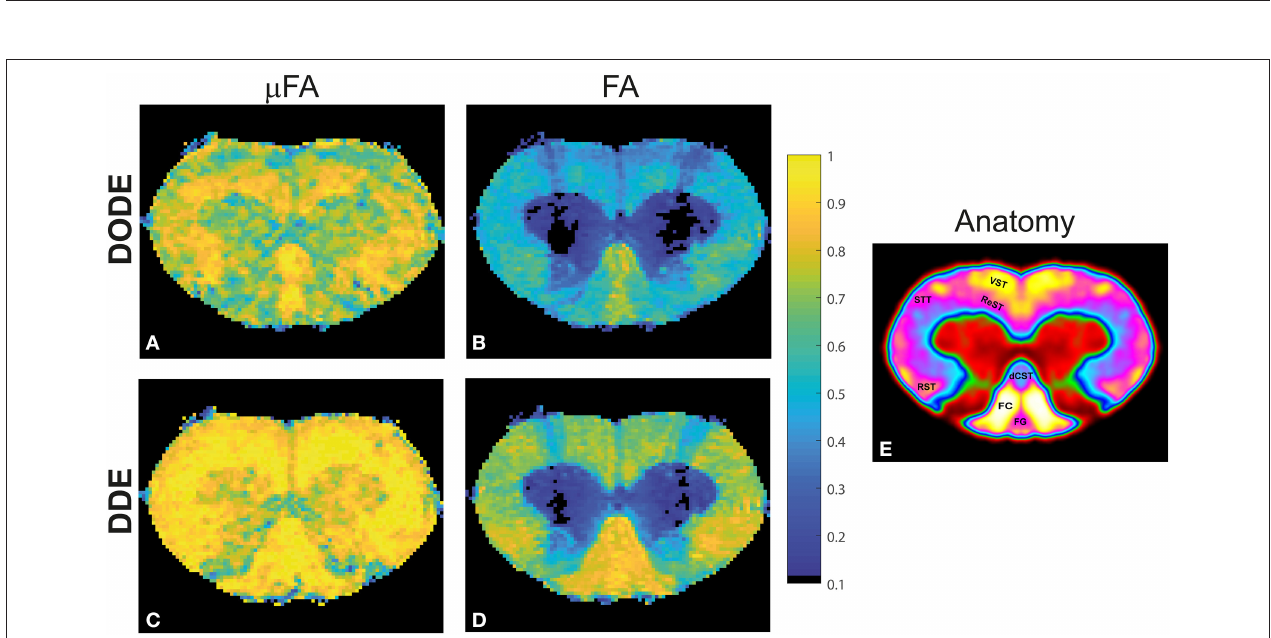
FIGURE 3 | Parameter maps for a representative spinal cord. (A) µ FA DODE ; (B) FA DODE ; (C) µ FA DDE ; (D) FA DDE . Notice the differences in contrast both in white and in gray matter tissues both between metrics and between sequences. Most notably, µ FA is higher than FA and DDE-driven metrics are higher than DODE-driven metrics, especially in white matter. (E) Anatomy of the spinal cord for reference, displayed over a smoothed false-color image of the cervical segment. The gray matter is shown in red and green, while the tracts are highlighted on the left side of the cord.